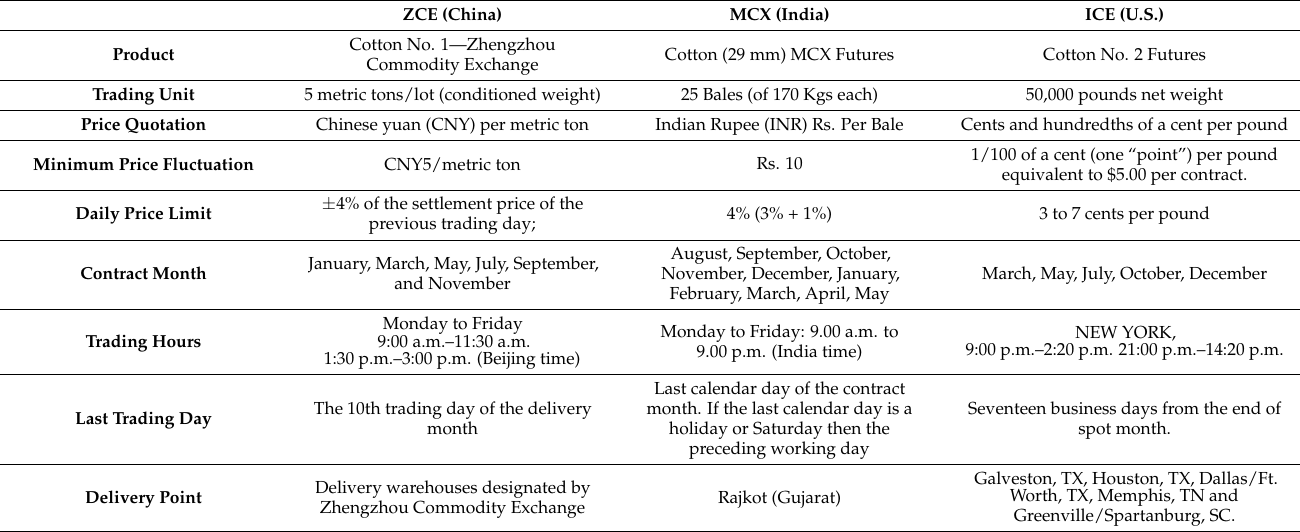
Table 2. Details of Cotton Contract traded on ICE, ZCE, and